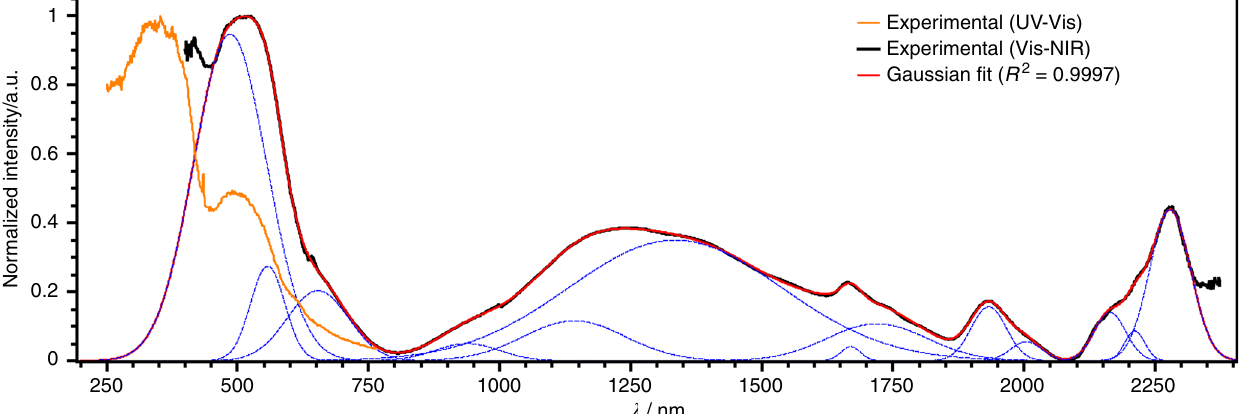
Fig. 4 Comparison of electronic absorption spectra of MOF-CoNDI-py-2. The spectra were collected in the UV – Vis (orange) and Vis – NIR (black) range. Mathematically deconvoluted Gaussians for the Vis – NIR, only, are shown in blue dashed lines. The sum of all individual Gaussians is shown in red